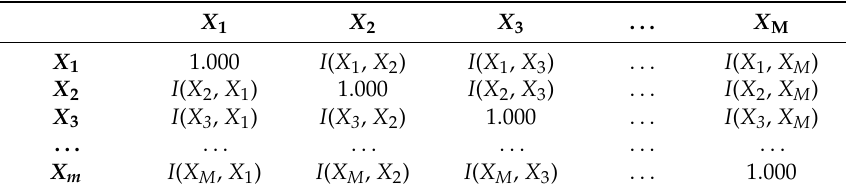
Table 2. Structure of normalized mutual information contingency